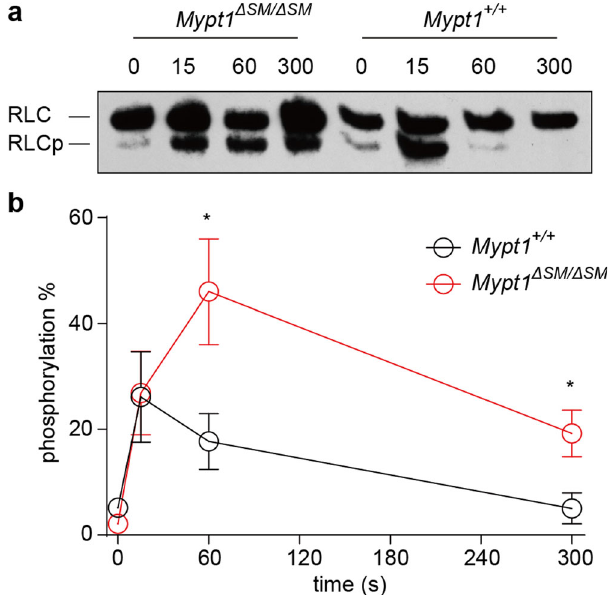
Fig. 3 RLC phosphorylation in MYPT1-de fi cient dorsal arteries in response to PE stimulation. Dorsal arteries of MYPT1 KO ( Mypt1 Δ SM/ Δ SM ) and control ( Mypt1 + / + ) mice were collected and stimulated with 10 μ M PE. The stimulated arteries were sampled for RLC phosphorylation via urea/ glycerol PAGE. a Representation of typical RLC phosphorylation assay results after stimulation. b Quanti fi cation of RLC phosphorylation. The RLCp level was expressed as the percentage of the total RLC level. The bars indicate the mean values ± SEM; n = 5; * p < 0.05; t